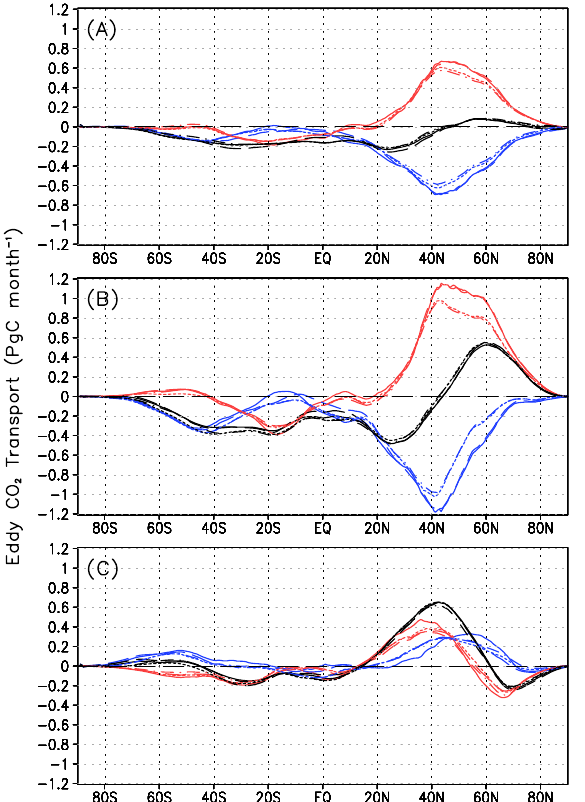
Fig. 1. Zonal-mean column integrated meridional CO 2 transport av- eraged over (A) 1yr, (B) December-January-February and (C) June- July-August. Total meridional transport is shown in black, “mean” transport in blue, and “eddy” transport in red. Line styles cor- respond to transport by the four meteorological analyses, where G5F05 is cyan and solid, G5R10 as blue and dashed, G4F10 is green and dotted, and G4R20 is red and dash-dotted.